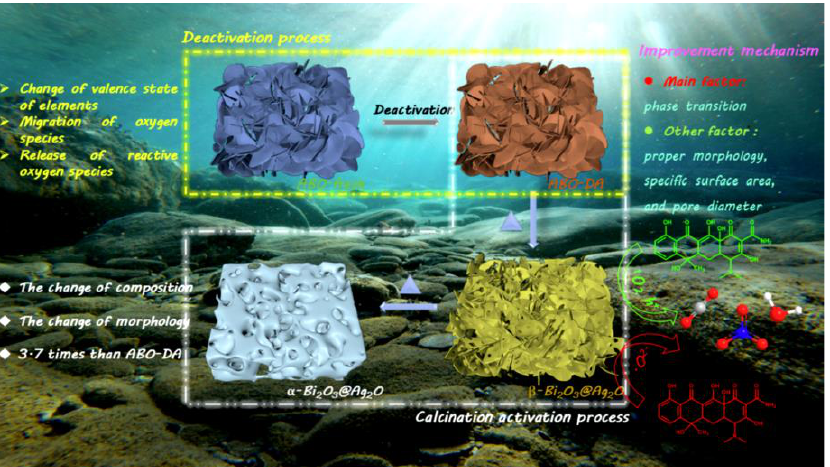
Figure 5. Possible reaction mechanism of the silver–bismuthate system. Reproduced with permission from [99]. Copyright 2022 Elsevier.